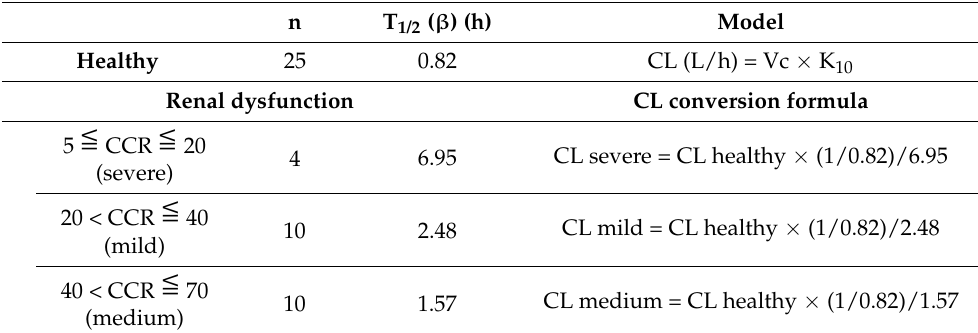
Table 3. Pharmacokinetics parameters of flomoxef. Pharmacokinetics Parameter Calculation Formula for Flomoxef by Renal Function; As